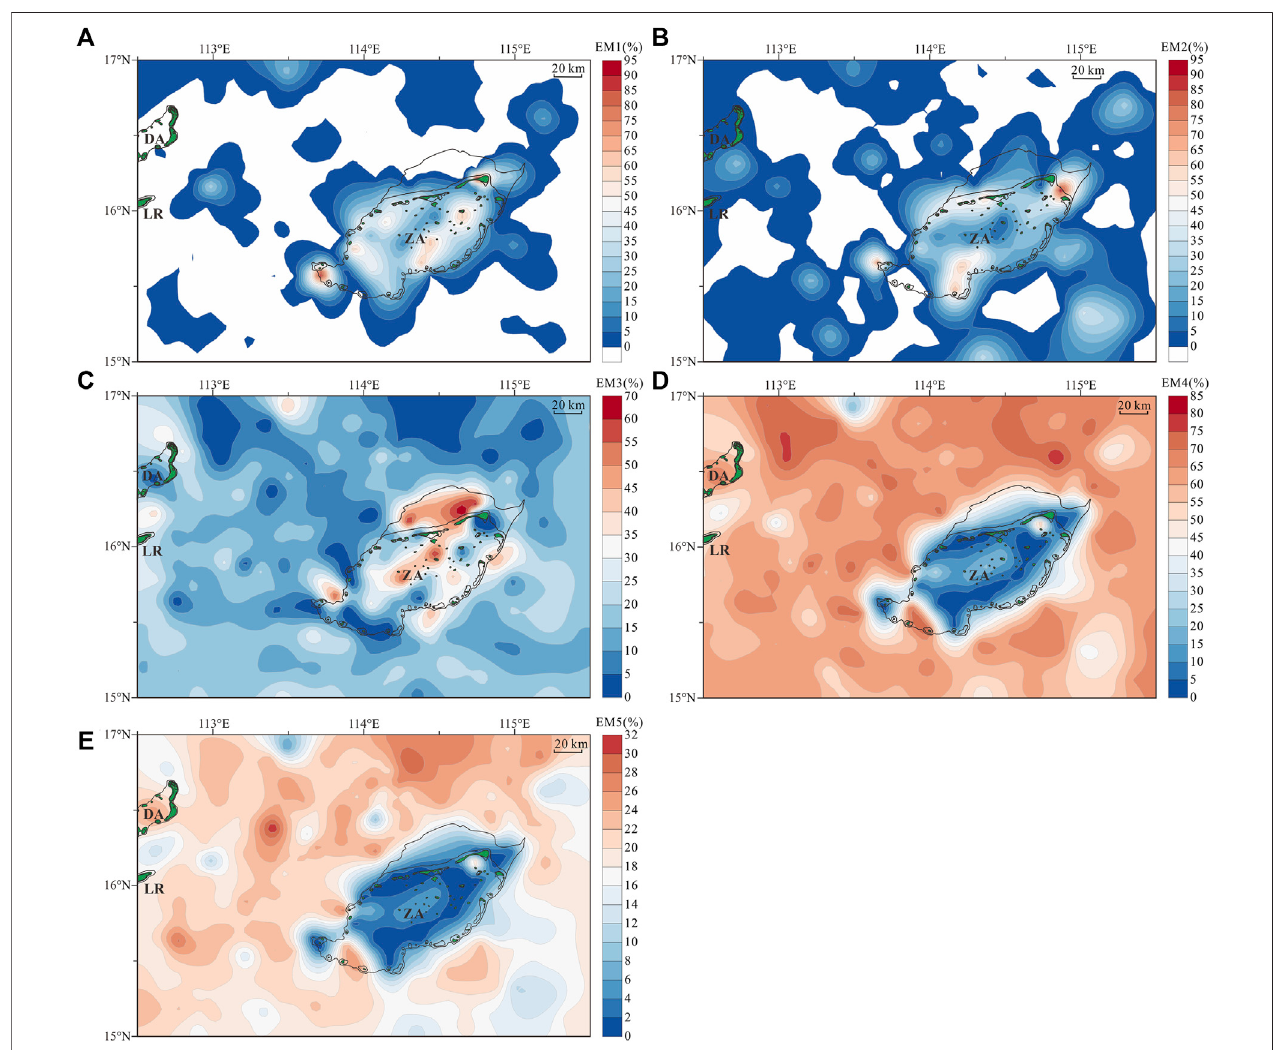
FIGURE 7 | Spatial distribution of fi ve end-members in the study area, including (A) EM1, (B) EM2, (C) EM3, (D) EM4, and (E) EM5.